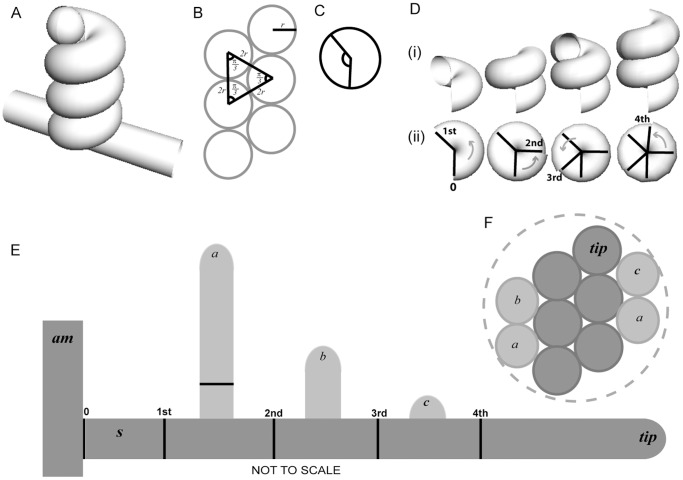
Simulation of the transition from two-dimensional hyphal growth into a three-dimensional helical object representing the ascogonial coil.(A) Mathematically drawn model of an ascogonial coil, helix (cos t, sin t, t) from t = 0 to 6π (3 full circles). The ascogonial mother-cell is shown as a cylinder and the hyphal tip of the coiling branch is represented as a hemisphere. (B) A vertical cross-section through the coil shown in (A) where the distance between the centers of each circular cross-section is equal to the hyphal diameter (2r). (C) Diagram indicating the angle 2.4 rad (∼137.5°). (D) Position of septa from microscopical observations of numerous ascogonial coils in N. crassa. Septa are usually observed around two thirds of a revolution (240°) apart, after the coil-tip has made more than one complete revolution (2π rad or 360°). The angle between projected septa is likely to be optimized around 2.4 rad for maximum structural strength and this is represented here in the cut-away sections (i) of the coil shown in (A). (ii) The positions of the subsequent septa are shown in top view. The angle between ‘septa’ approximates to 2π–2.4 rad (∼222.5°). (E) Diagrammatic representation of an unwrapped-coil (not to scale), showing septation (black vertical lines) and branching of successive enveloping hyphae: (a), (b), and (c) (paler grey) of the coil. Branching is assumed here to occur equidistant between septa, although, in vivo the branching sometimes appears nearer to one septum. A stalk-cell is often observed in vivo. The diagram illustrates this with a basal septum (0) making a ‘stalk-cell’ compartment (s) next to the ascogonial mother-cell (am). (F) Extrapolated representation of a vertical cross-section of a simulated ascogonial coil, which has been wrapped by enveloping hyphae that would have originated from the septated compartments shown in (E). Note that the resulting coiled structure (not to scale) is approaching that of a sphere (represented by the dashed outer-circle). N.B. In vivo, enveloping hyphae tend to be narrower in diameter than the ascogonial mother-cell.